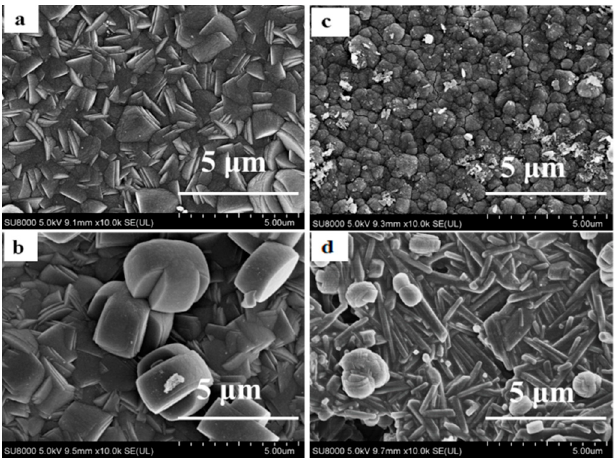
Figure 10. Outer ( a and c ) and inner ( b and d ) surface images of the bi-layer (M-10, a and b) and mono-layer (M-3, c and d) TS-1 zeolite membranes.